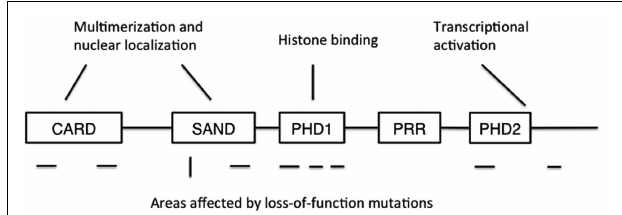
FIGURE 1 |The structure ofAIRE protein . CARD: caspase recruitment domain; SAND: human Sp100, Aire1, NucP41/P75, and Drosophila DEARF1 domain; PHD: plant homeodomain; PRR: proline-rich region. CARD and SAND are associated with AIRE multimerization and nuclear localization, while PHD1 mediates binding to non-methylated histone H3. Mutations disrupting AIRE’s function have been found in all domains except PRR,